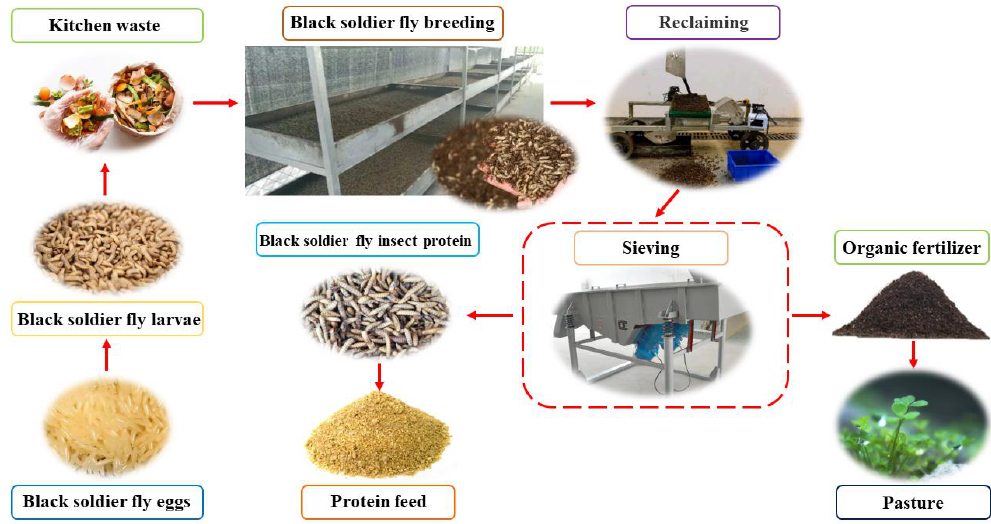
Figure 1. Collection and sorting process of black soldier fly sand mixture .